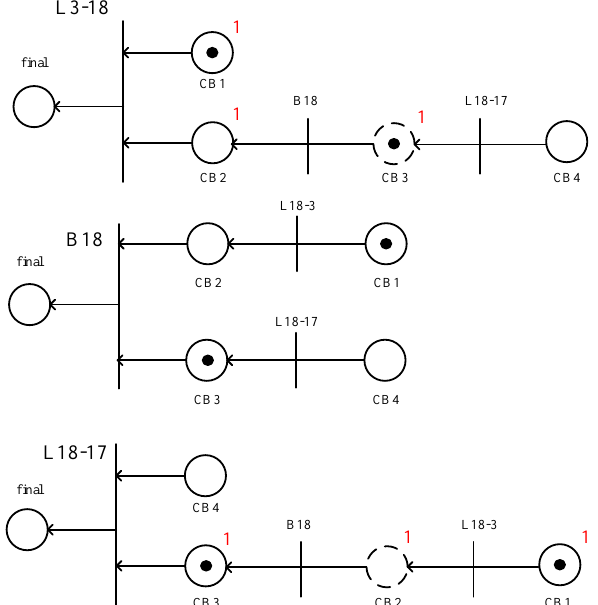
Figure 12. The backward reasoning Petri net of each element.